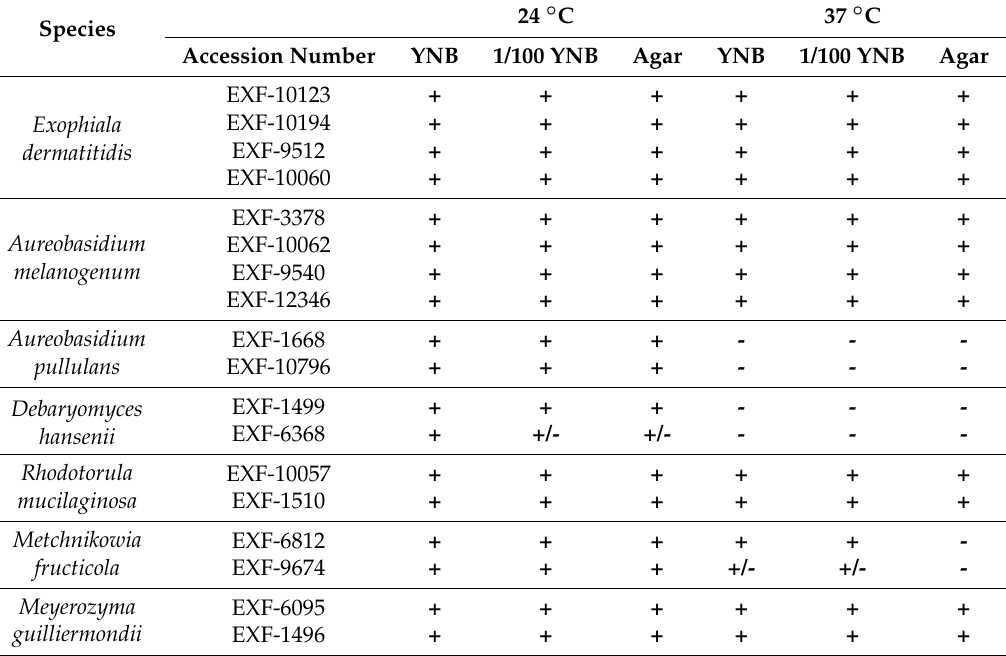
Table 2. Growth of the selected yeast strains at 24 ◦ C and 37 ◦ C on yeast nitrogen base (YNB), 100-fold diluted YNB (1/100 YNB) and pure agar medium (Agar).